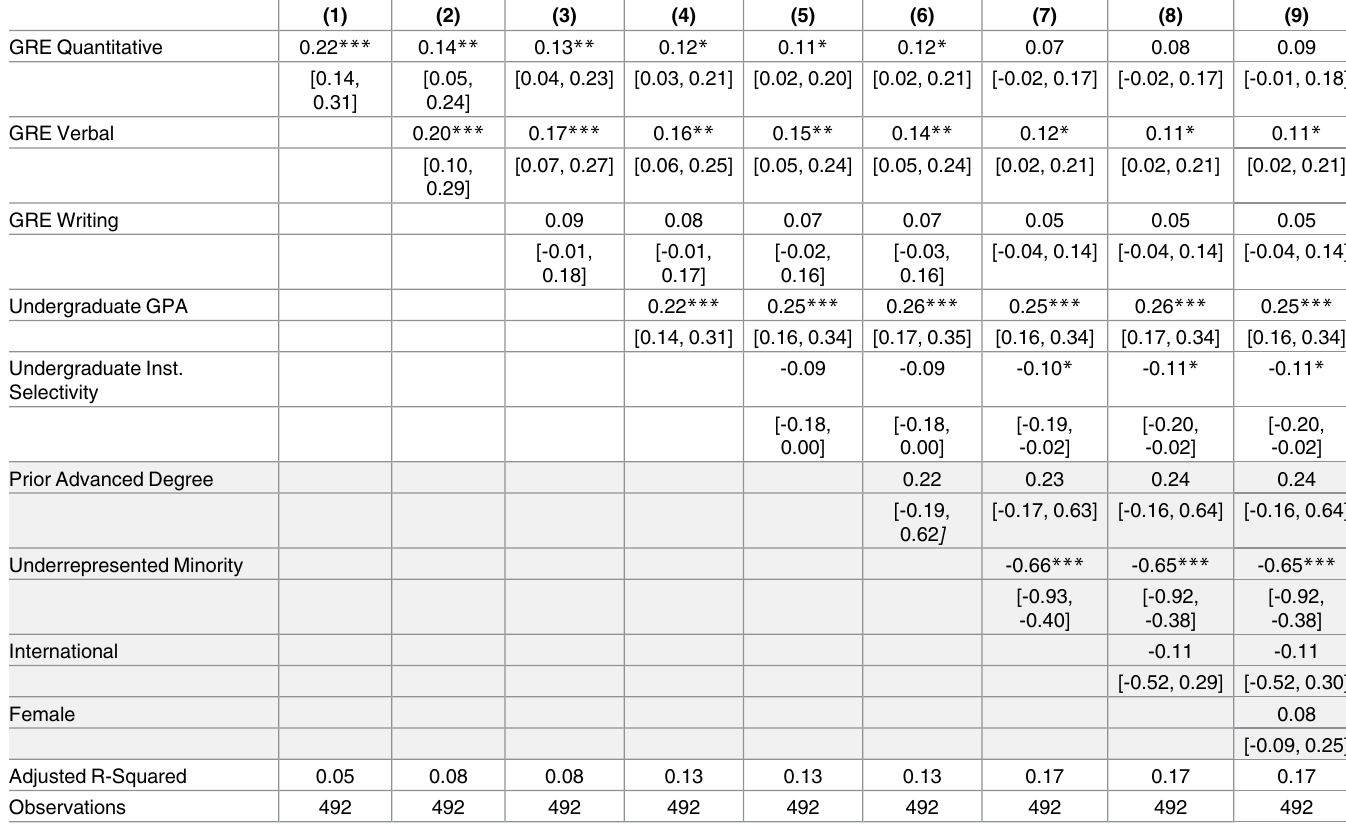
Table 4. The predictive power of GRE scores and other admissions criteria on Graduate GPA.